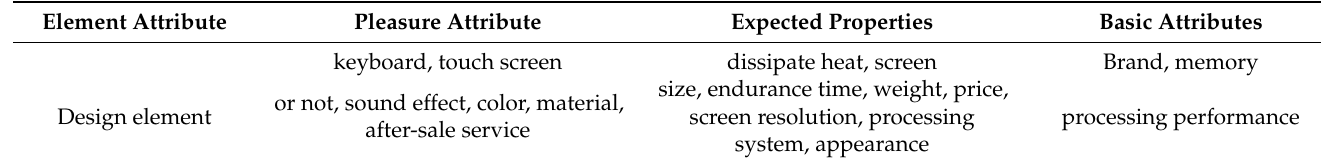
Table 7. User requirement hierarchy division of laptop’s design element attribute.